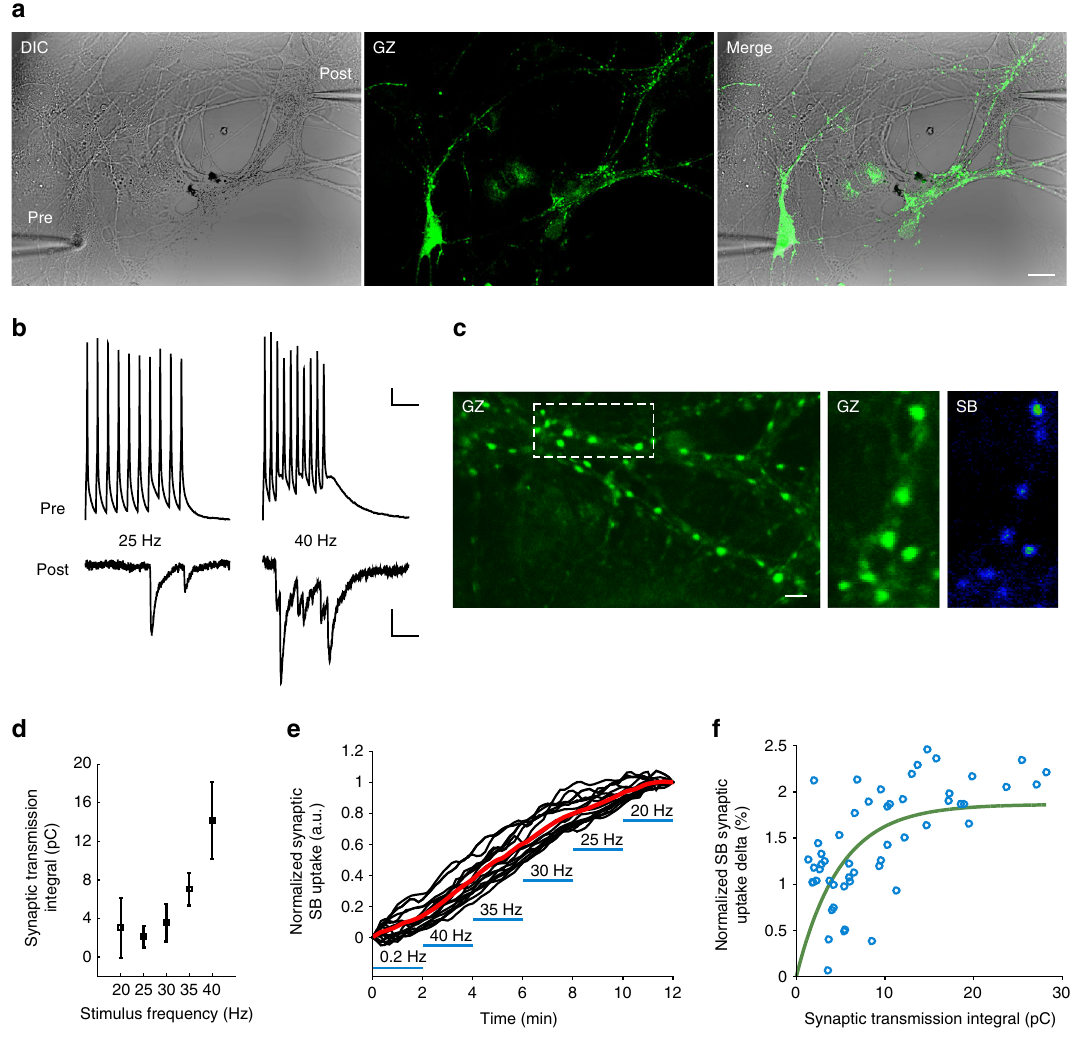
Fig. 3 Synaptic transmission and SB uptake at hippocampal synapses. a – f Simultaneous electrophysiological and optical recording from a pair of synaptically connected hippocampal neurons (representative experiment from N = 5 pairs). a Images of the pre-synaptic and post-synaptic cells (left, DIC image; middle, in green GZ expression in the presynaptic cell; right, merge). b Evoked trains of action potentials in the presynaptic neuron (top traces) and the corresponding synaptic currents in the postsynaptic cell (lower traces) at two stimulation frequencies (25 and 40 Hz, 10 action potentials per train; trains applied every 5 s). c A subset of synapses, to illustrate reporter expression (GZ) and the effect of action potential trains on SB uptake (SB). d Analysis of the strength of synaptic transmission at different presynaptic stimulation frequencies (20 – 40 Hz trains as in b ), indicating facilitation of EPSC amplitude. e Time-course of SB uptake (normalized for its fi nal value) for N = 18 synapses belonging to the same axon at variable stimulation frequencies. f Percent increment of SB uptake for individual trains and synapses (synaptic charge and SB uptake were averaged over trains at the same stimulation frequency; same synapses shown in e ). The green line is the fi tting trace with a mono-exponential curve. Notice that the correlation approaches a ceiling for very high postsynaptic current values. Scale bars: 20 µ m ( a ), 10 mV or 25 pA, 100 ms ( b ), 5 µ m ( c